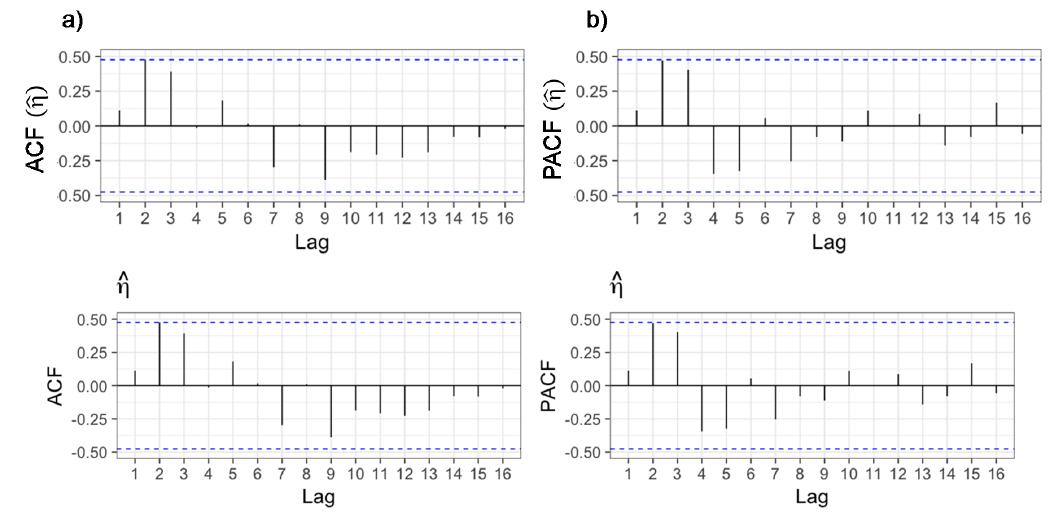
Figure 10. ( a ) Cross-correlation and ( b ) partial autocorrelation functions (ACF and PACF, respectively) of the estimated residuals ( ˆ η t ) for the fitted